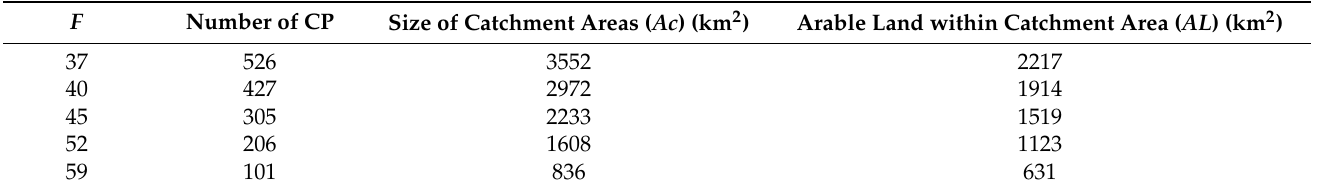
Table 2. Examples of selection of CPs according to the value of the indicator of critical conditions F .